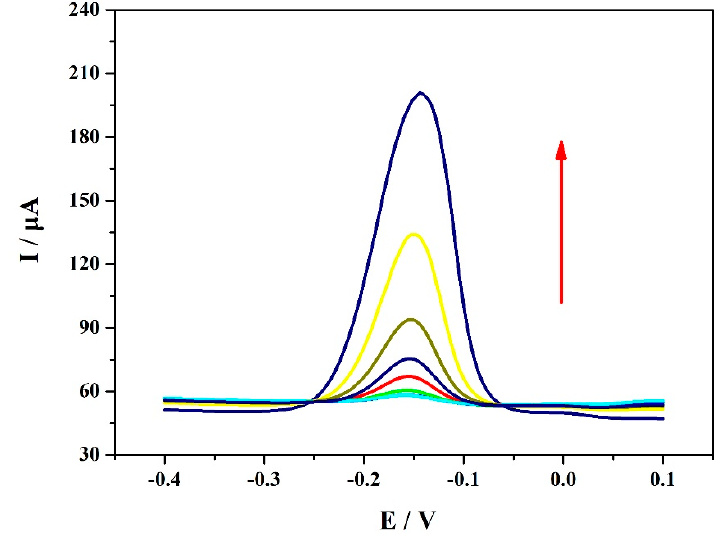
Figure 8. DPV for the determination of MP in 0.1 M PBS (pH = 7.0) with VXC-72R/ZrO 2 /GCEs at MP concentrations ranging from 1 to 100 μ M (1, 3, 5, 7, 9, 10, 30, 50, and 100 μ M).